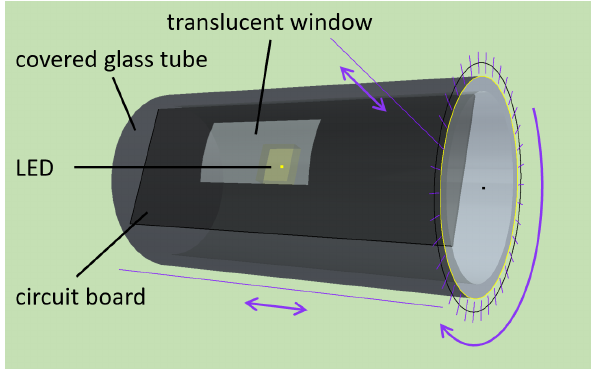
Figure 5. Experimental measurement configuration of the glass tube.